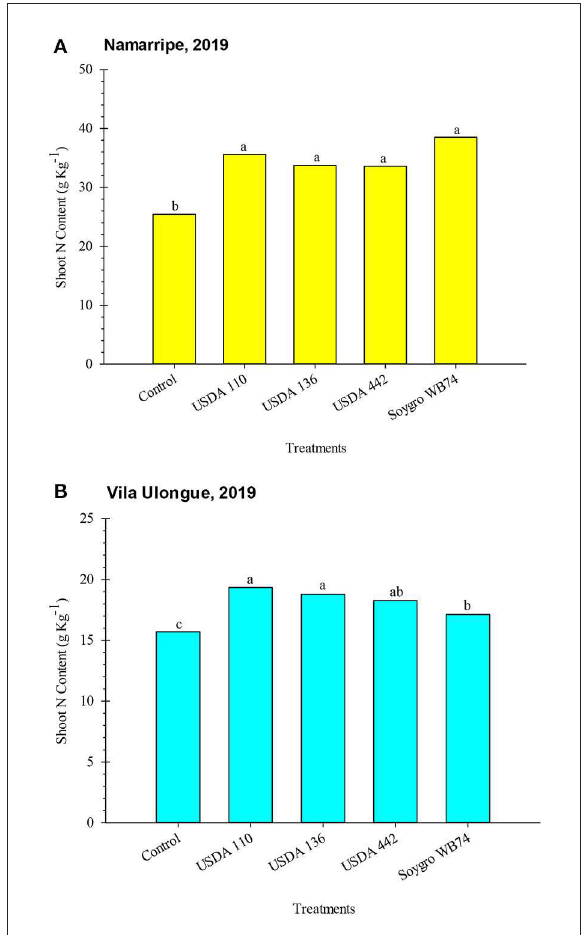
FIGURE2 Shoot N contents of soybean inoculated with varoius inoculant strains at Namarripe (A) and Vila Ulongué (B) , Mozambique. Means within a location followed by the same letter are not significantly different at P < 0.05 according to LSD.